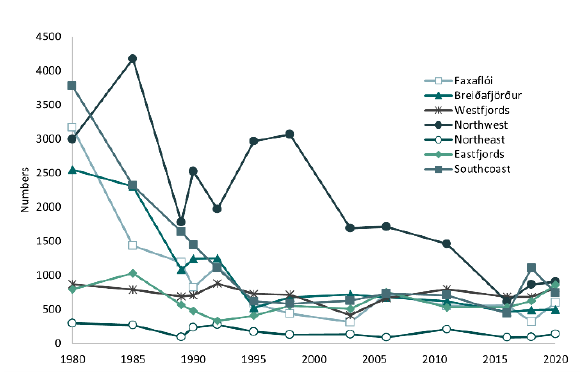
Figure 3: Number of counted animals for each coastal sub-area over the period 1980–2020.